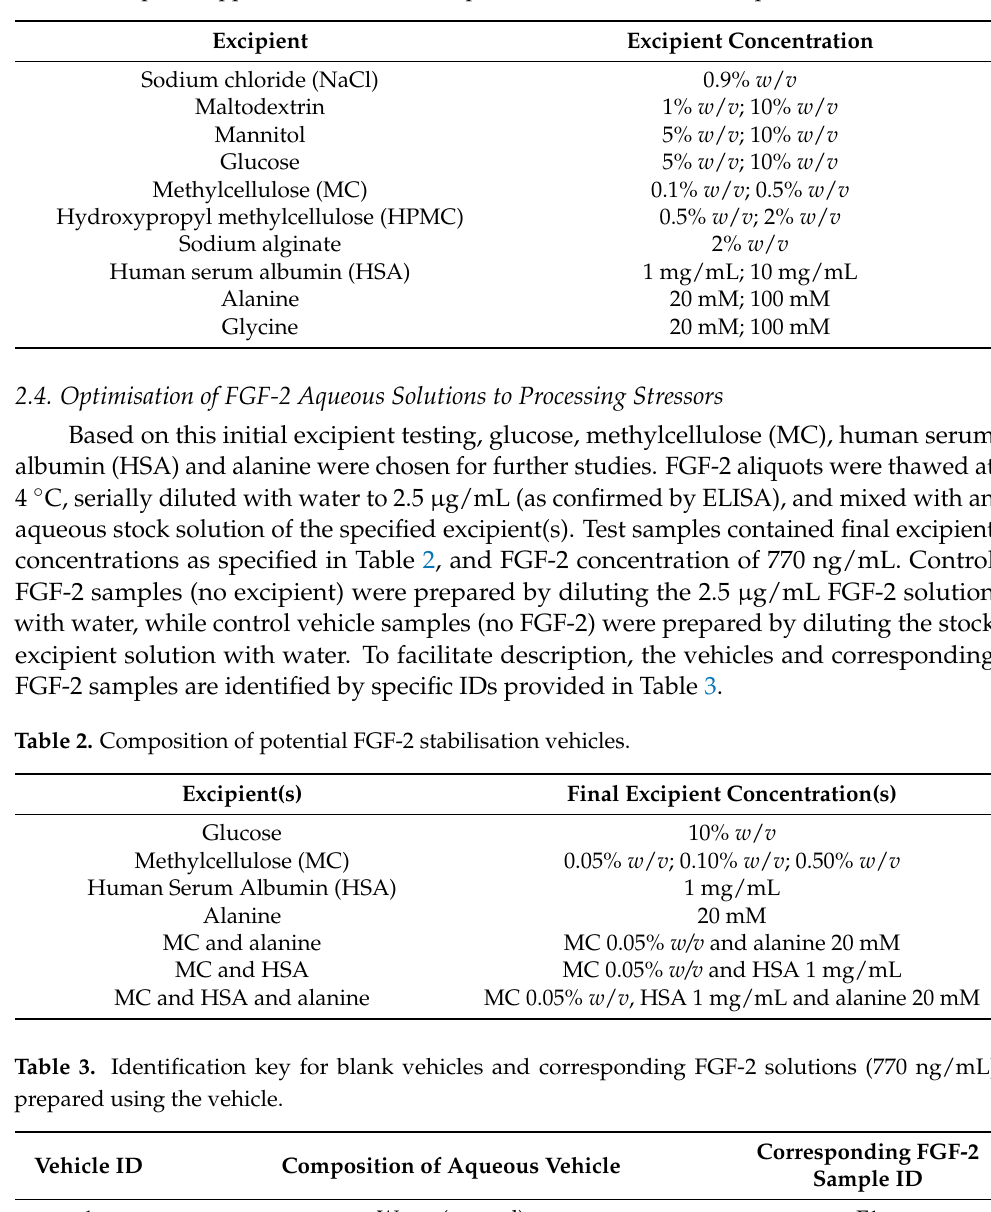
Table 1. Excipients applied to assess for their potential to stabilise FGF-2 aqueous solutions.